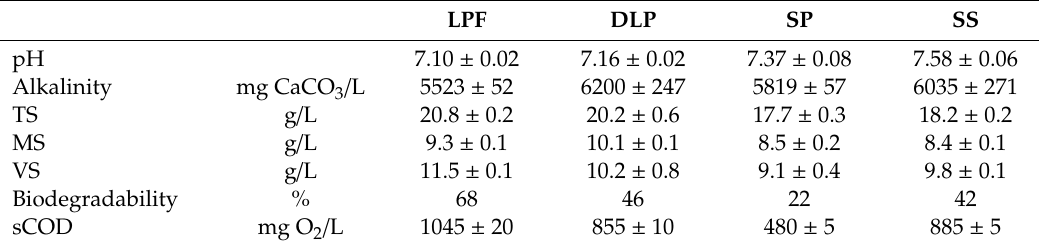
Table 3. pH, Alkalinity, TS, MS, VS, Biodegradability and soluble COD in the biochemical methane potential tests at the end of the experimental